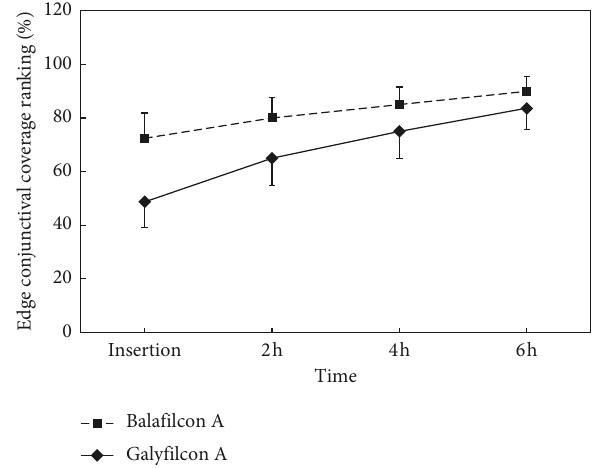
Figure 2: Time-dependent overlap of conjunctiva at lens edge. The average conjunctival overlap increased significantly at 6 hours after insertion. Balafilcon A lenses had more conjunctival overlap than the galyfilcon A lenses. Galyfilcon A lenses had showed greater increase in tendency of conjunctival overlap over time. Bars denote 95% confidence interval